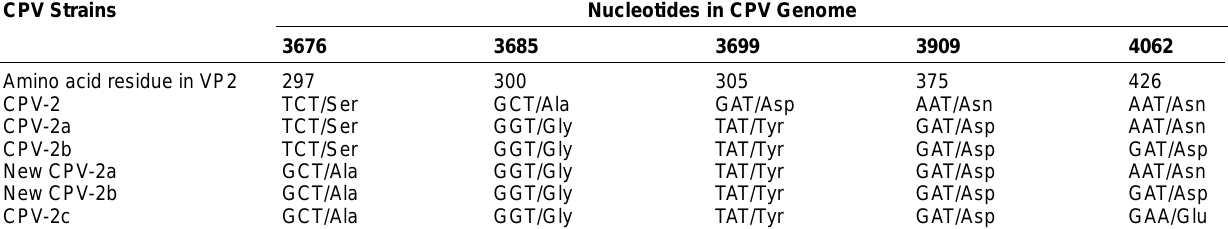
Table-3. Nucleotides and amino acid variation in the VP2 protein of different CPV-2 CPV